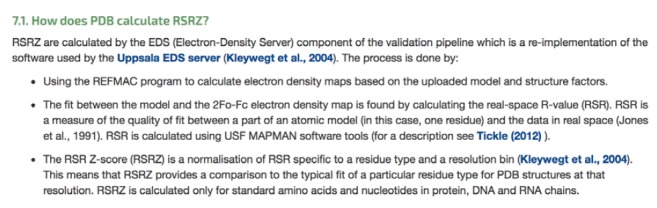
DOI:
http://dx.doi.org/10.7554/eLife.22567.025